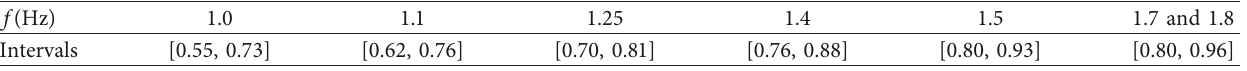
Table 6: C values of 95% confidence